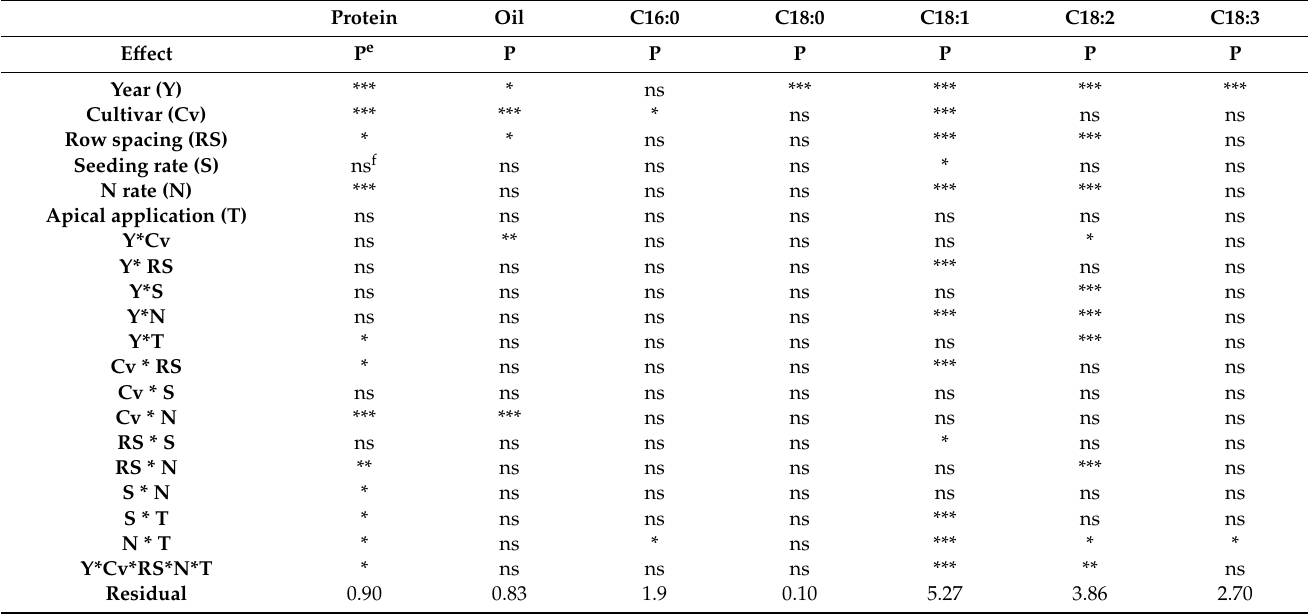
Table 1. Analysis of variance (P values) for the e ff ect of main e ff ects of year (Y), cultivar (Cv), row spacing (RS), seeding rate (S), nitrogen rate (N), apical application (T), and their interactions on seed composition (protein, oil, palmitic (C16:0), stearic (C18:0), oleic (C18:1), linoleic (C18:2), and linolenic (C18:3 acids) (%). The experiments were conducted in 2015 and